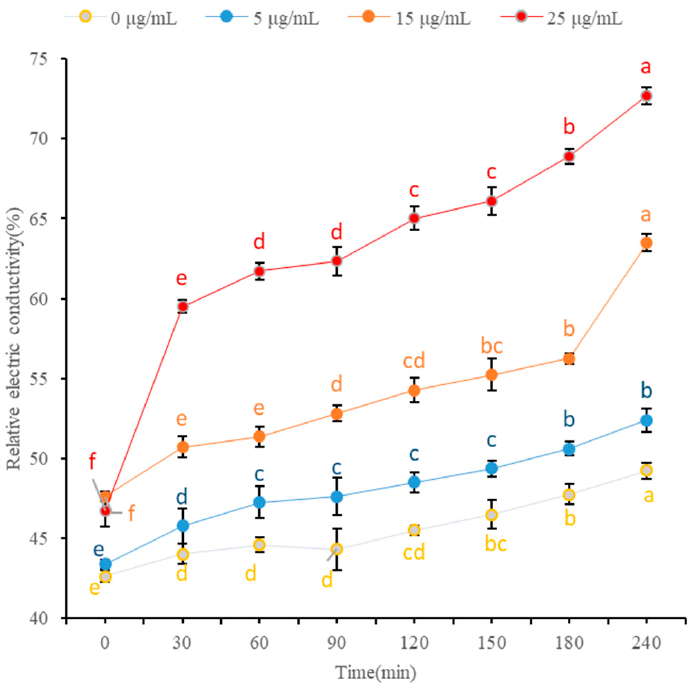
Figure 7. Changes in cell membrane permeability of W12 against S. sclerotiorum (Different letters indicate significant differences at p < 0.05 in the same group).